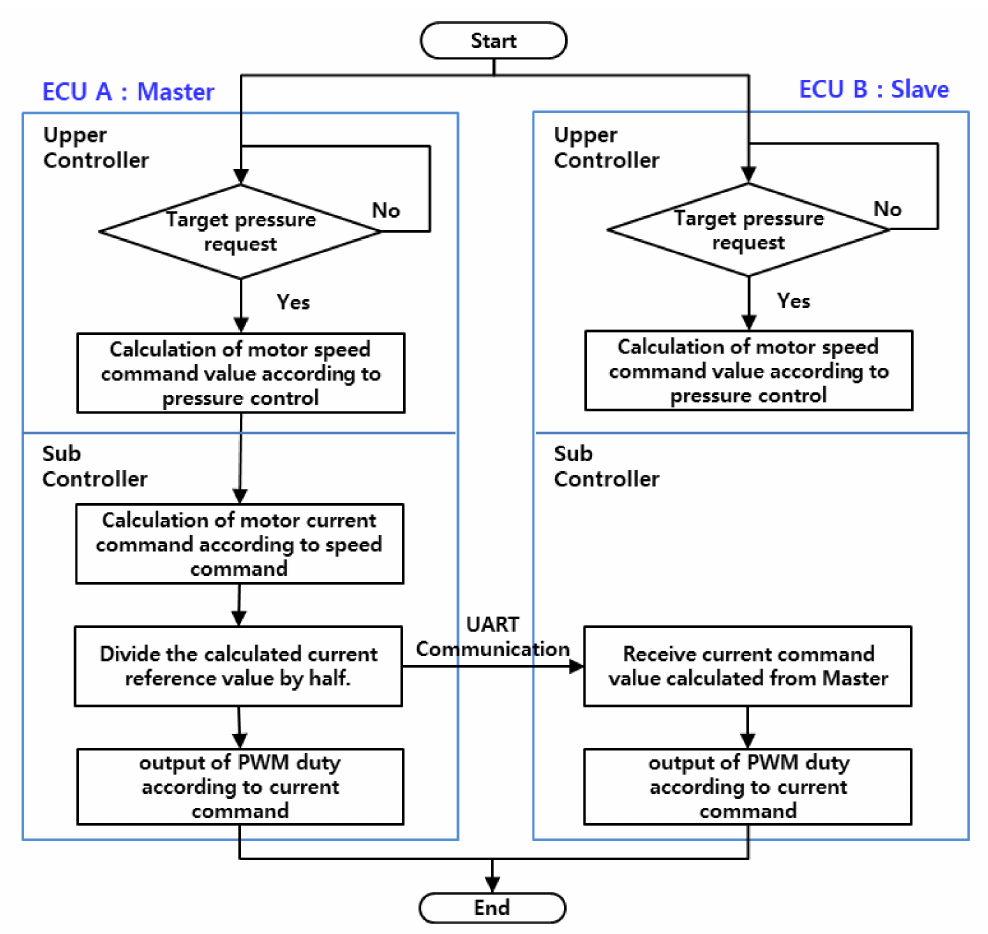
Figure 8. Flowchart of the proposed current control method in the normal